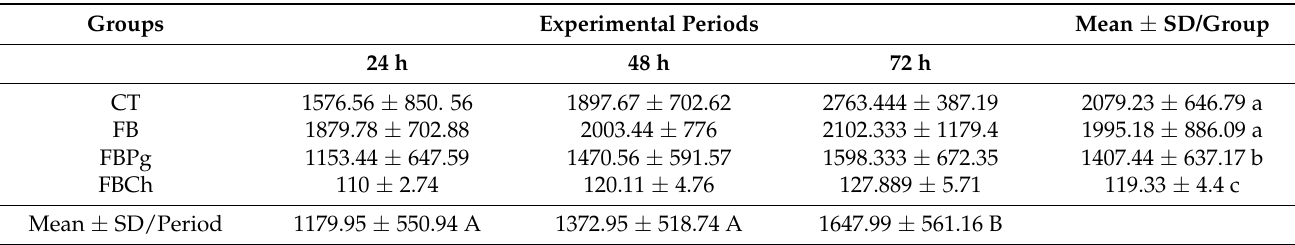
Table 3. Mean absorbance values (nm) ± standard deviations (SD) of the metabolic activity of the C. albicans biofilm for the adhesives tested on specimens made with conventional heat polymerized